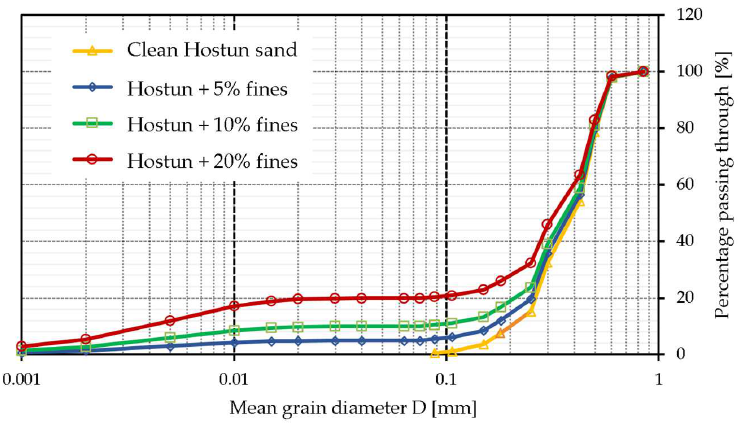
Figure 5. Grain size distribution of the tested materials.